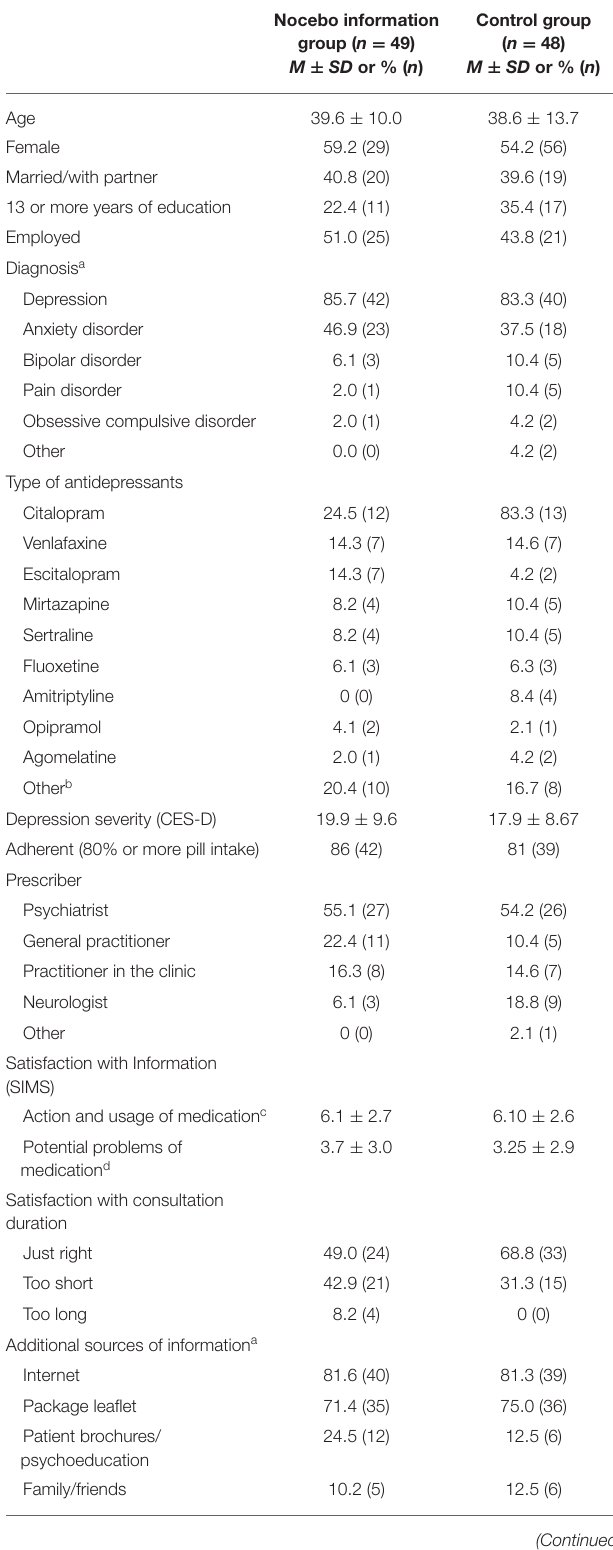
TABLE 1 | Socio-demographic, medical characteristics, and satisfaction with medication